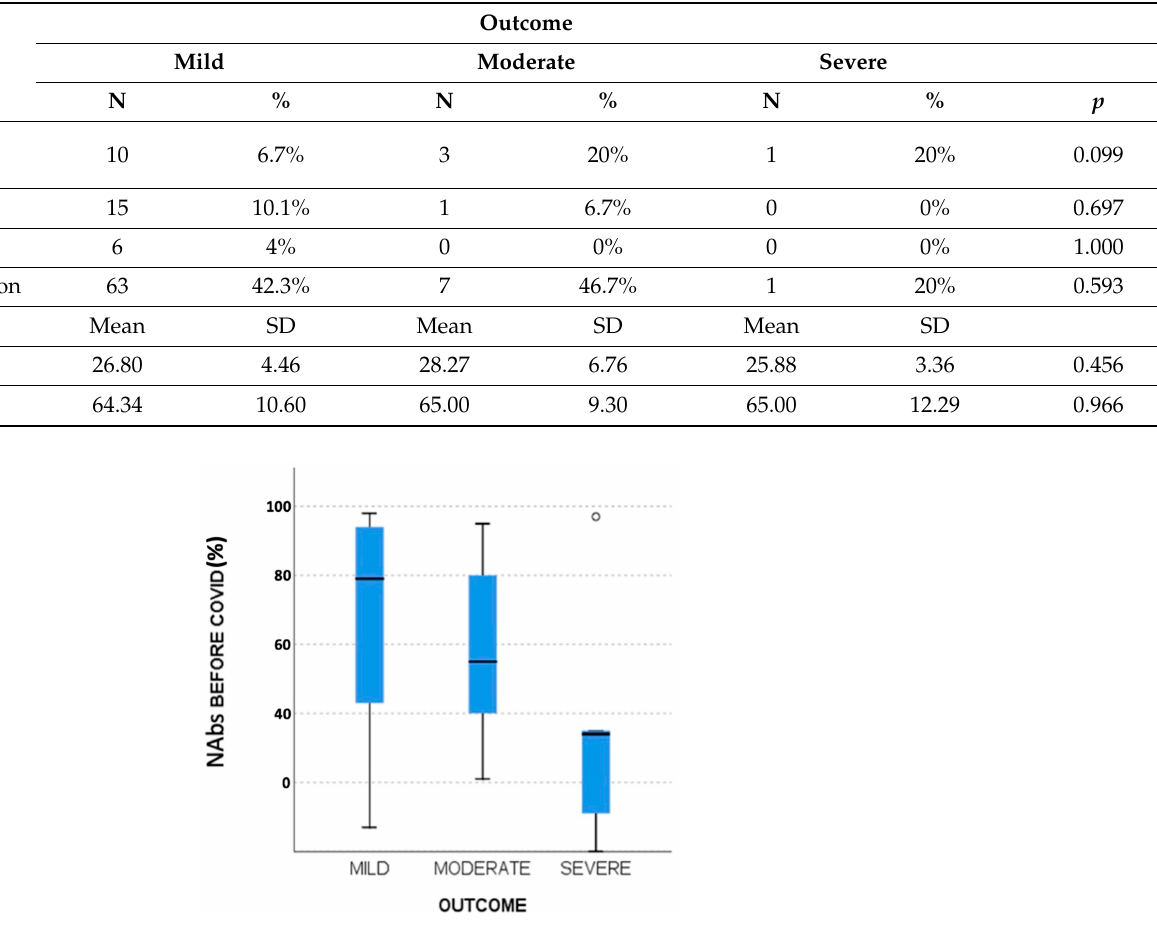
Figure 1. Boxplot of the differences in NAbs before SARS-CoV-2 infection based on COVID-19 out- comes.